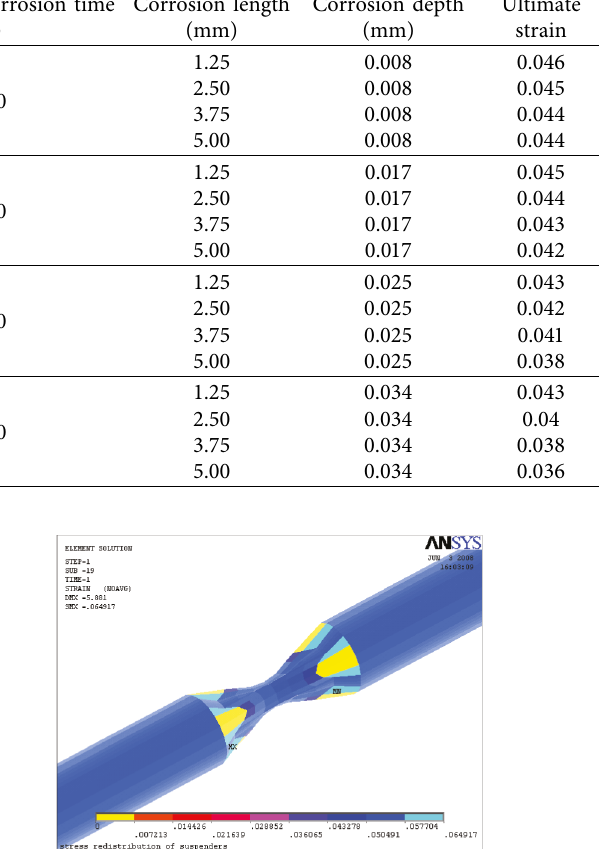
Figure 6: “Cup-cone” fracture of the uniformly corroded steel